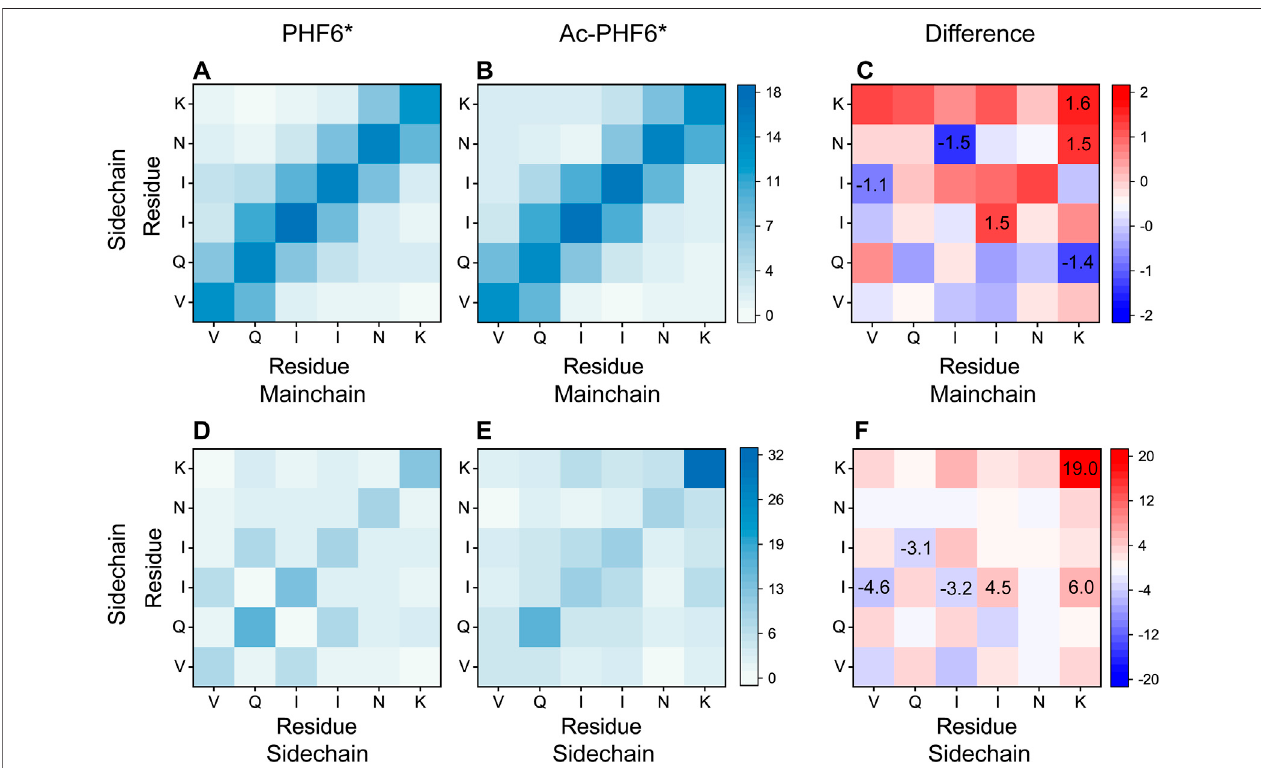
FIGURE7| AnalysesoftheeffectofacetylationonMC-SCandSC-SCcontactnumbermapsforPHF6*oligomerinthePHF6* (A,D) andAc-PHF6* (B,E) systems. MC-SC (C) and SC-SC (F) contact number maps for the difference between PHF6* and Ac-PHF6* systems. The contact number is normalized with the total peptide chain number of 12 in each